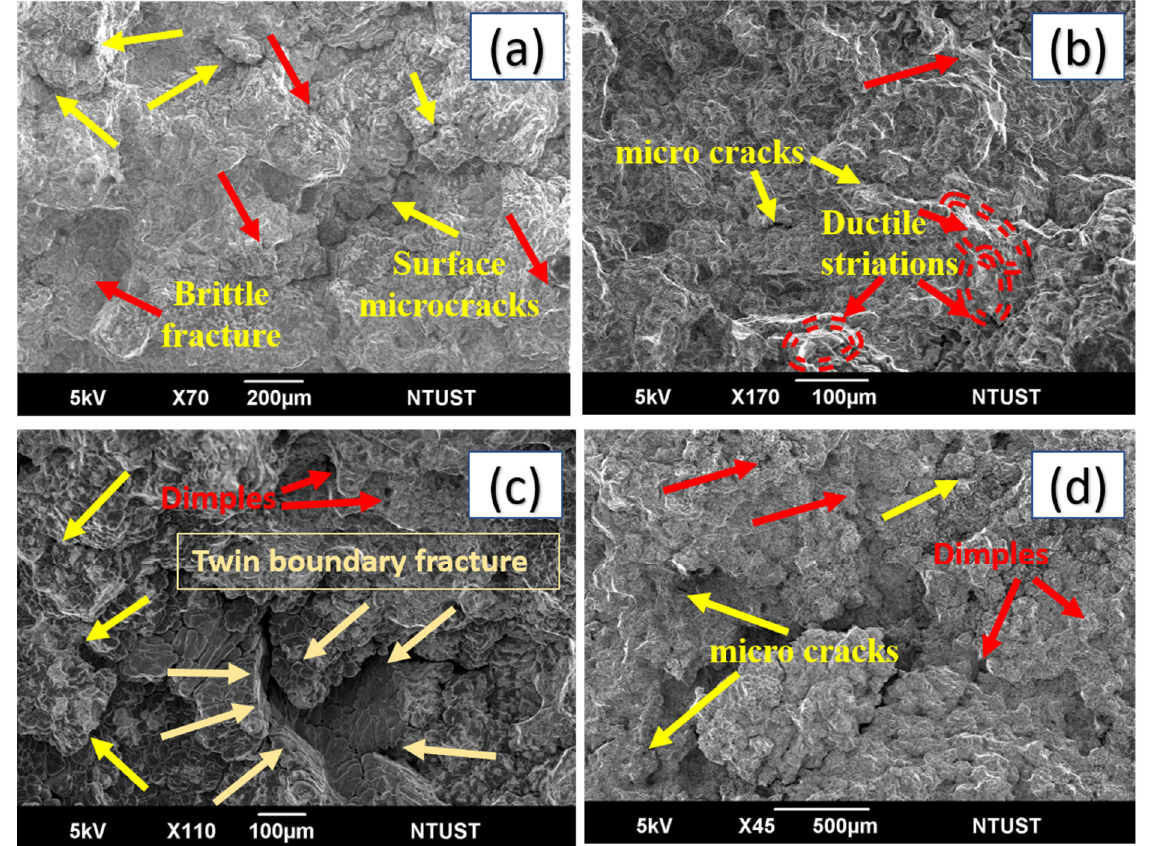
Figure 12. Fractography of the tensile-ruptured surfaces of ( a ) pure AZ91 matrix, ( b ) AZ91 + 0.5 wt.% SiCp, ( c ) AZ91 + 1 wt.% SiCp and ( d ) AZ91 + 0.5 wt.% SiCp + 1 wt.% Bi + 0.4 wt.% Sb.